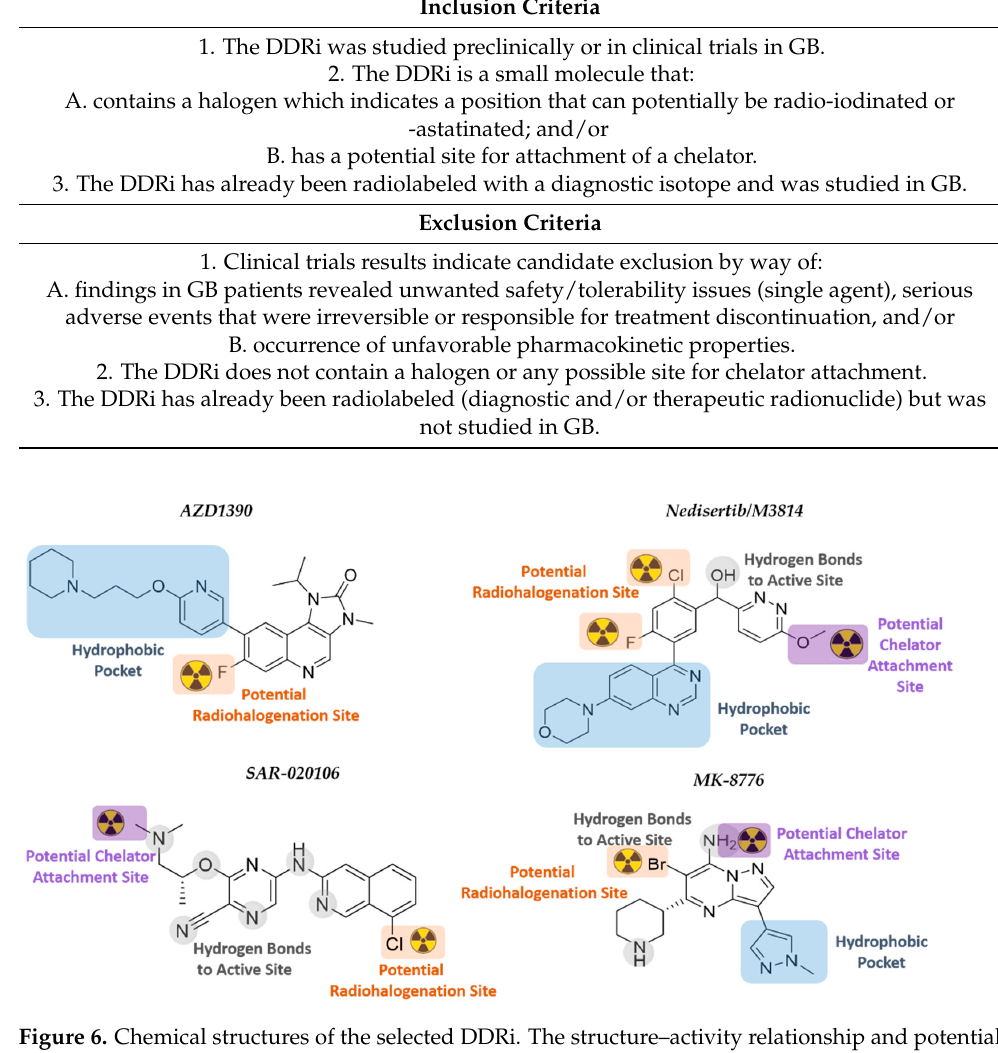
Figure 6. Chemical structures of the selected DDRi. The structure–activity relationship and potential radionuclide attachment sites are indicated. radionuclide attachment sites are